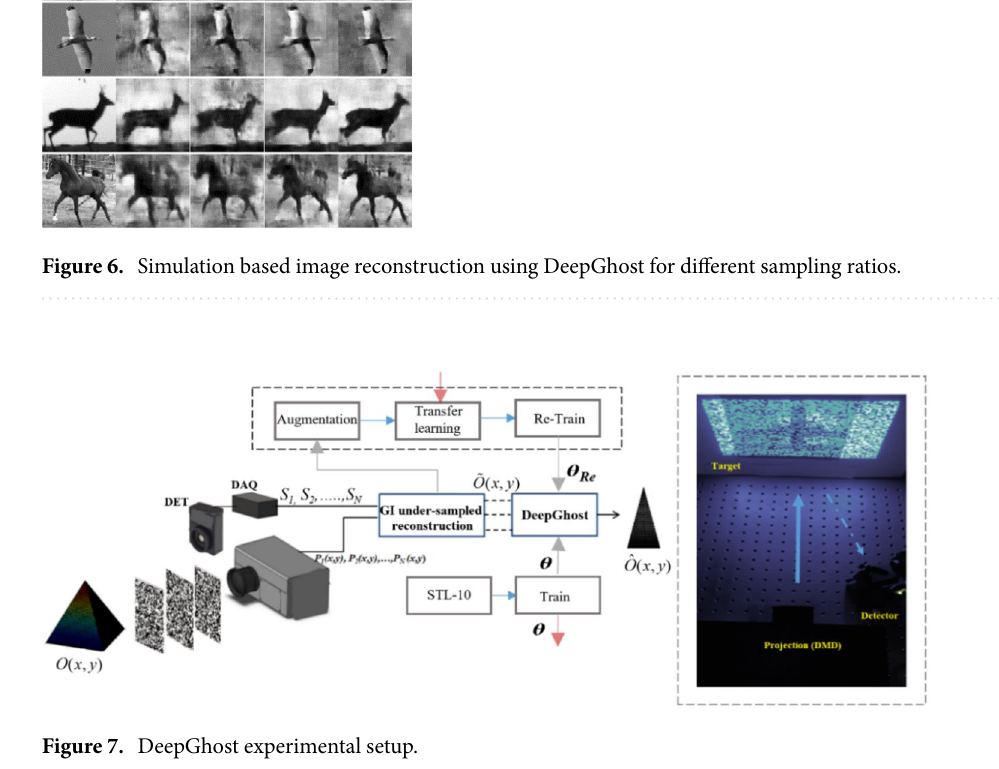
Figure 7. DeepGhost experimental setup.